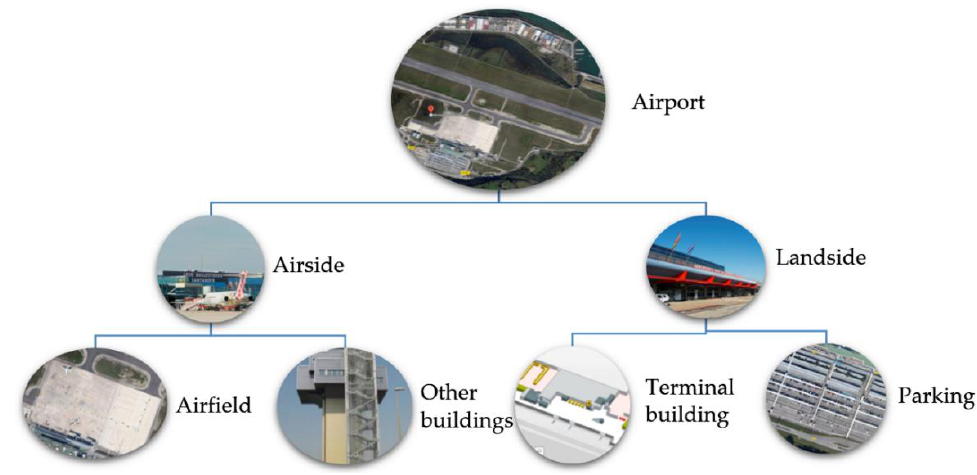
Figure 1. Scheme of main airport areas (Source: Airport Seve Ballesteros-Santander).